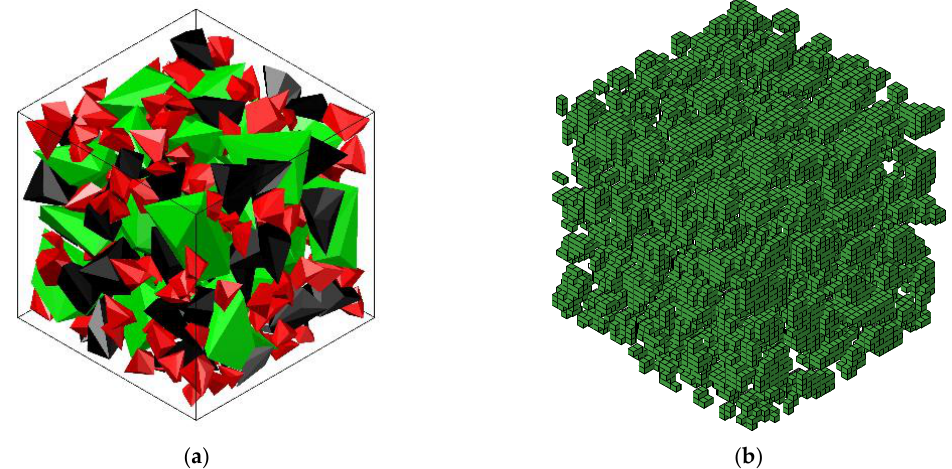
Sensors 2020 , 20 , x FOR PEER REVIEW Figure 16. The flowchart of the geometric modeling. Figure 16. The flowchart of the geometric modeling.